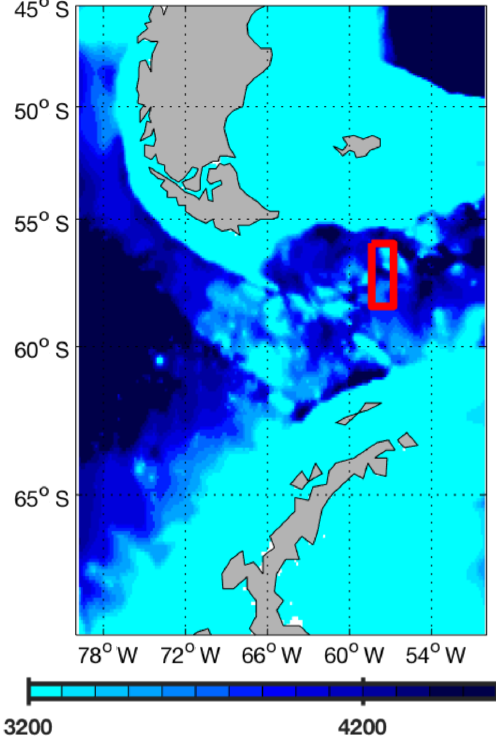
Figure 2. Close-up of MOMSO bathymetry in the Drake Passage. The color denotes depths in meters. The red rectangle denotes the area where, from 3250m down to the bottom, an additional Lapla- cian horizontal viscosity of 1000m 2 s − 2 is applied for stability rea-